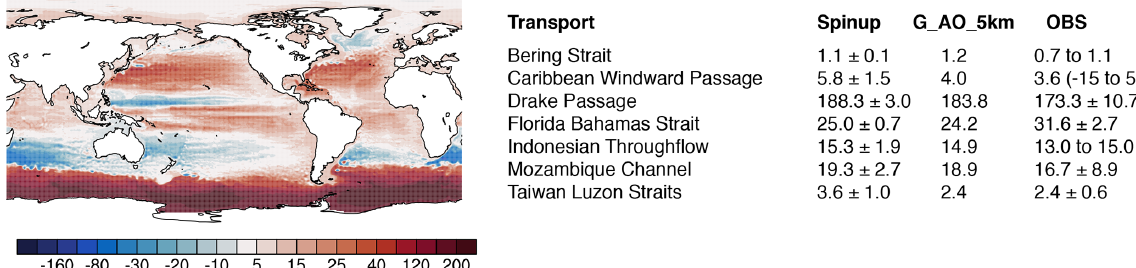
Figure 9. Barotropic streamfunction (Sv) with associated major transports that can be computed from the streamfunction. Observations for the historic period are taken from Table J2 of Griffies et al. (2016) except for the Drake Passage, which is taken from a more recent estimate (Donohue et al., 2016). In the table, the spin-up values are averaged over the years 2015–2021 with 1 standard deviation indicated.